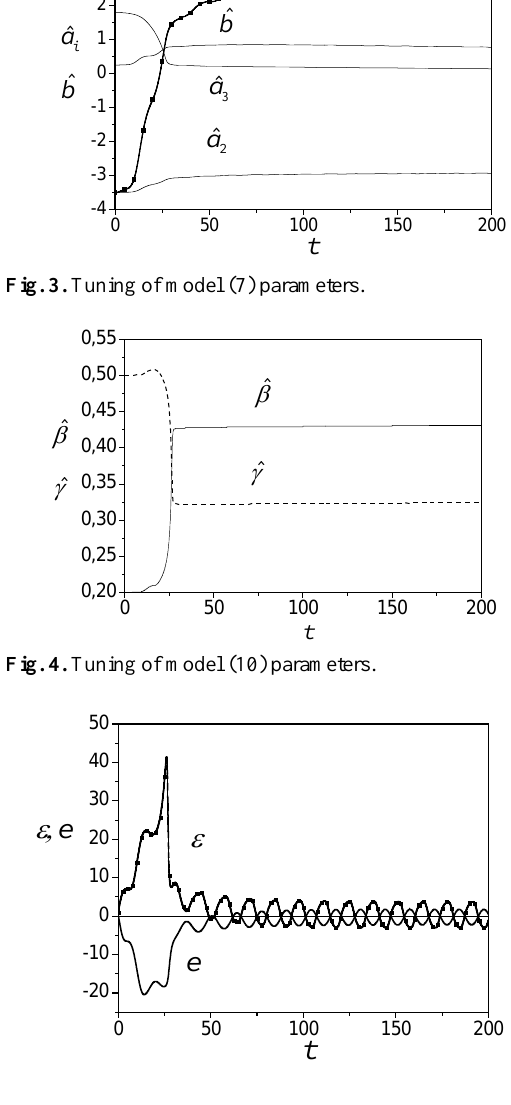
Fig. 5. Outputs modification of